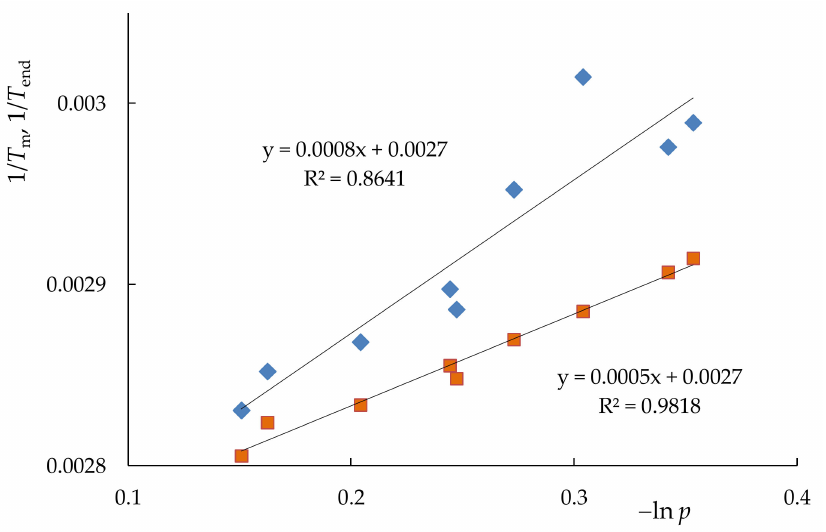
Figure 5. (Rhombs) maximums and (squares) ends of the DSC melting traces (Figure 4) in the coordinates of the Flory theory of polymer crystallization